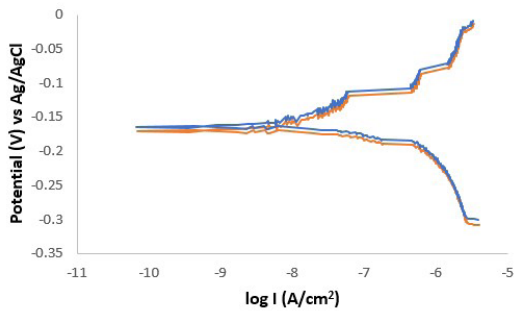
Figure 7. Tafel polarization curves corresponding to NAB samples tested in 3.5 wt.% NaCl solution for NAB alloy A (orange plot) and NAB alloy B (blue plot),